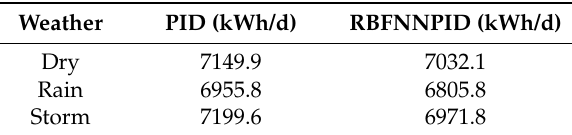
Table 2. Aeration energy of two control